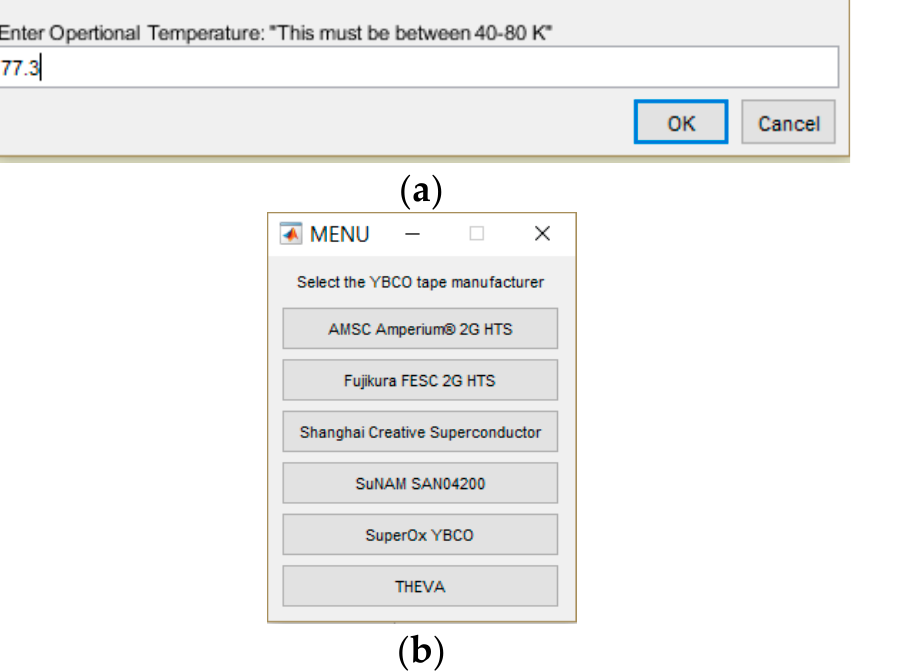
Figure 11. Quench probability calculation steps for different HTS tapes, ( a ) the related window to gain operational temperature. ( b ) the related window to select the type of HTS tape.